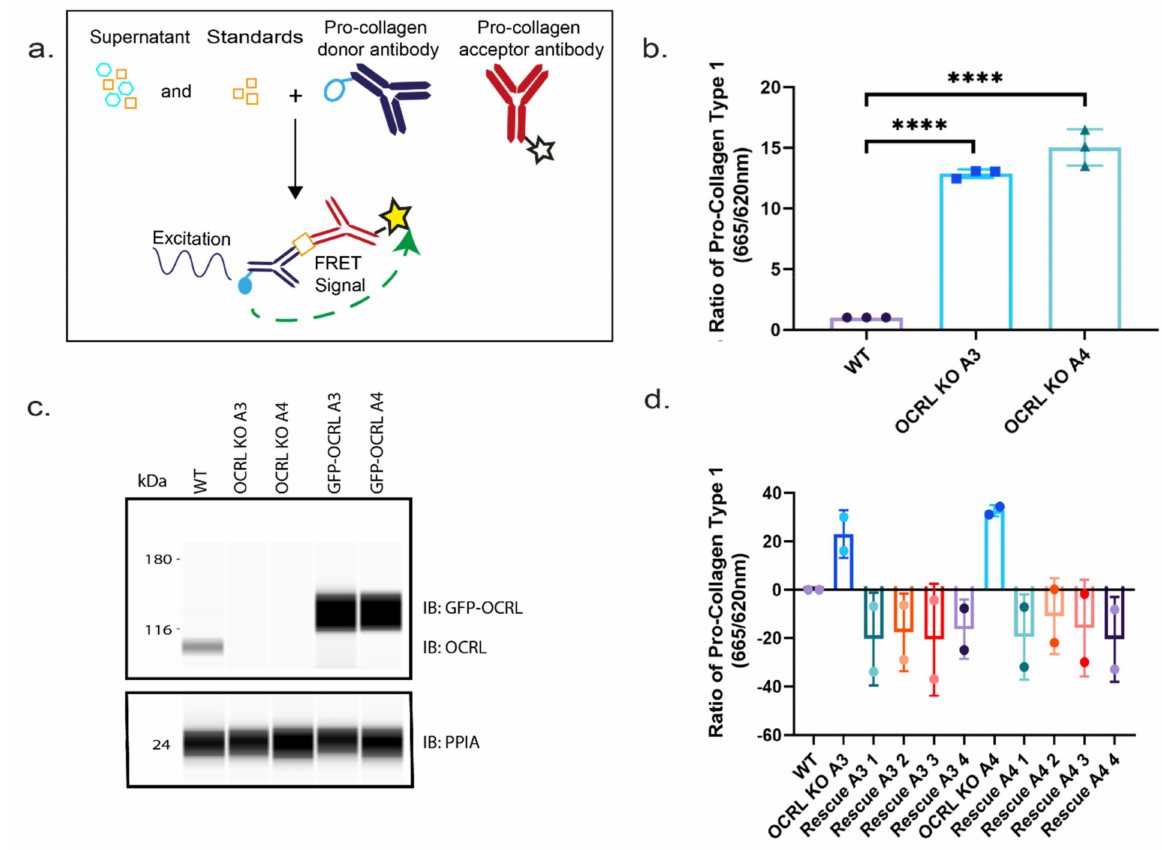
Figure 7. Collagen secretion: ( a ) the scheme of the FRET assay used to measure the levels of pro-collagen I in supernatants of cultured cells. ( b ) 3D experiment: graph showing quantitative analysis of collagen secretion measured via FRET assay in cultured cells’ supernatants. Ordinary one-way ANOVA and Dunnett’s multiple comparison test, N = 3 (>50 cells per N ), ****, p < 0.0001, error bars represent mean with ± SD. ( c ) Western blot showing the expression of GFP-tagged OCRL at approximately 135 kDa in OCRL KO clones with respect to HK-2 WT cell, with the expression of OCRL at approximately 110 kDa. ( d ) Graph showing the quantitative analysis of collagen secretion measured via FRET assay in cultured cells’ supernatants. Rescue cell lines showing decreased collagen secretion with respect to WT and a scatter dot plot showing the mean with SD, N =